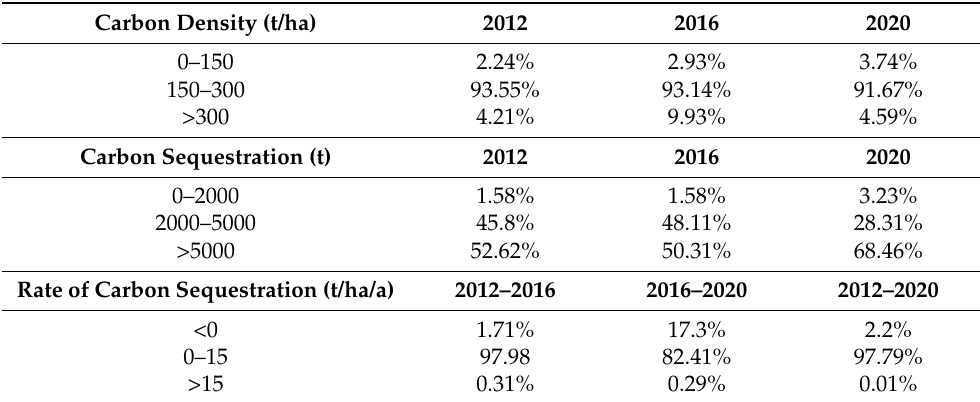
Table 2. Classification statistics of carbon sequestration.